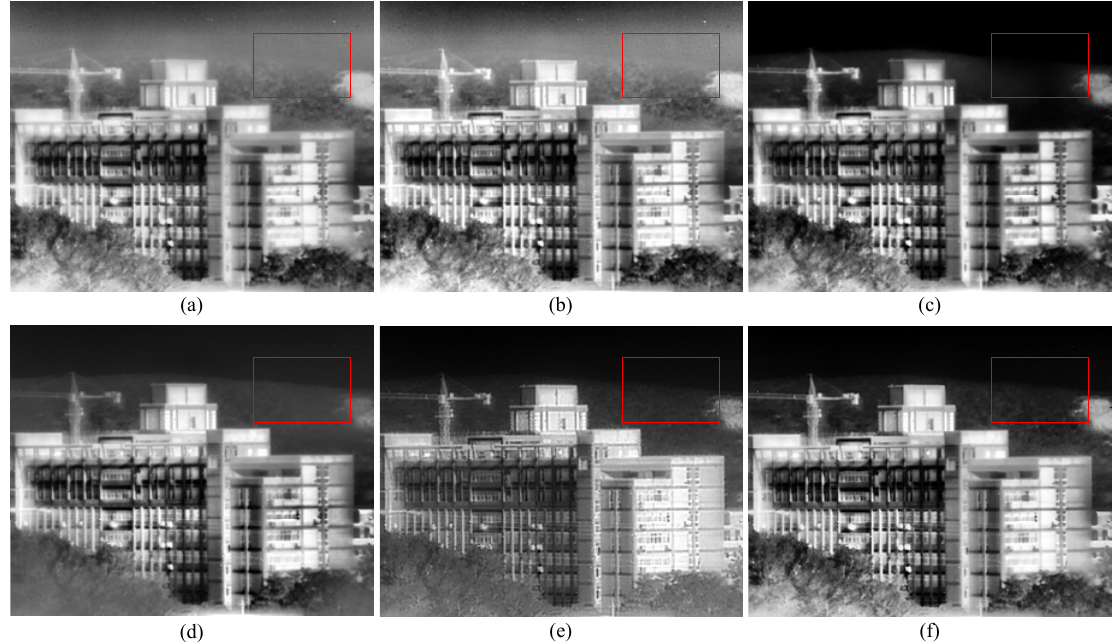
Figure 8. Enhancement results for Building1. ( a ) contrast-limited adaptive histogram equalization (CLAHE), ( b ) balanced CLAHE and contrast enhancement (BCCE), ( c ) adjacent-blocks-based modification for local histogram equalization (ABMHE), ( d ) local gradient-grayscale statistical feature (LGGSF), ( e ) global and local histogram specification (GLHS), ( f ) Proposed.